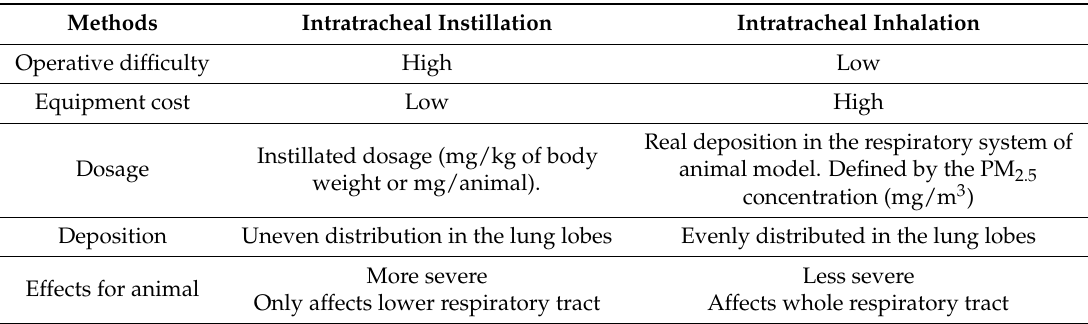
Table 3. Strengths and weaknesses of intratracheal inhalation and intratracheal instillation on PM 2.5 exposure to experimental